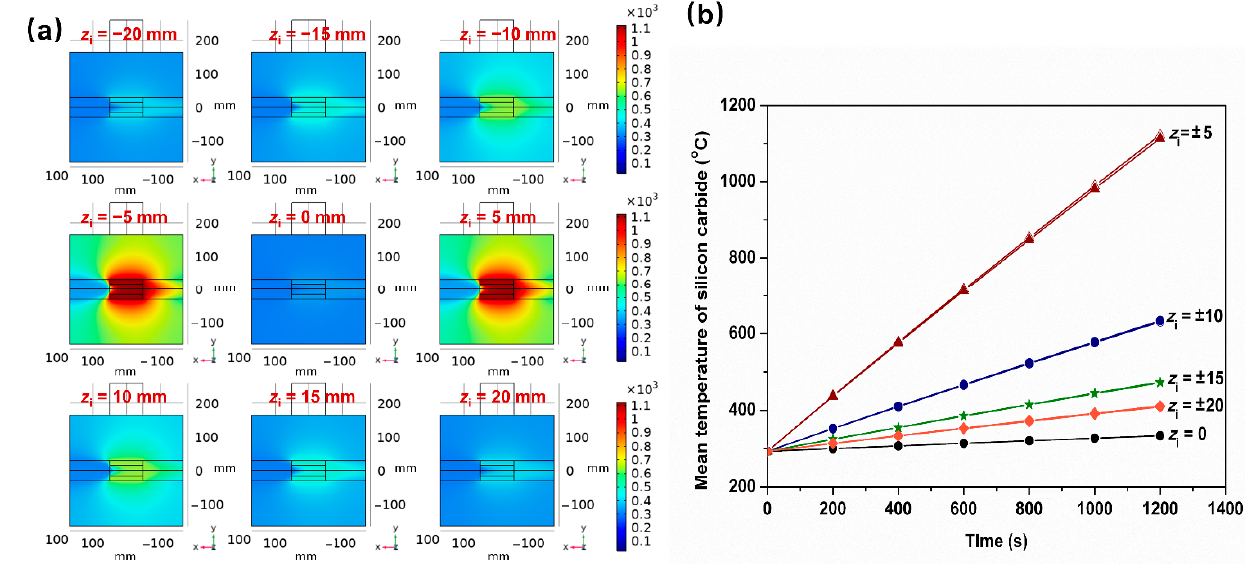
Figure 4. Effect of irradiation feed position on the simulated thermal fields (the temperature unit: K; x – y plane, z = 0; P = 1000 W; l SiC = 100 mm; v = 0.02 m/s): ( a ) variation of the thermal fields with different irradiation feed positions; and ( b ) the heating rate of silicon carbide under microwave irradiation with different irradiation feed positions.